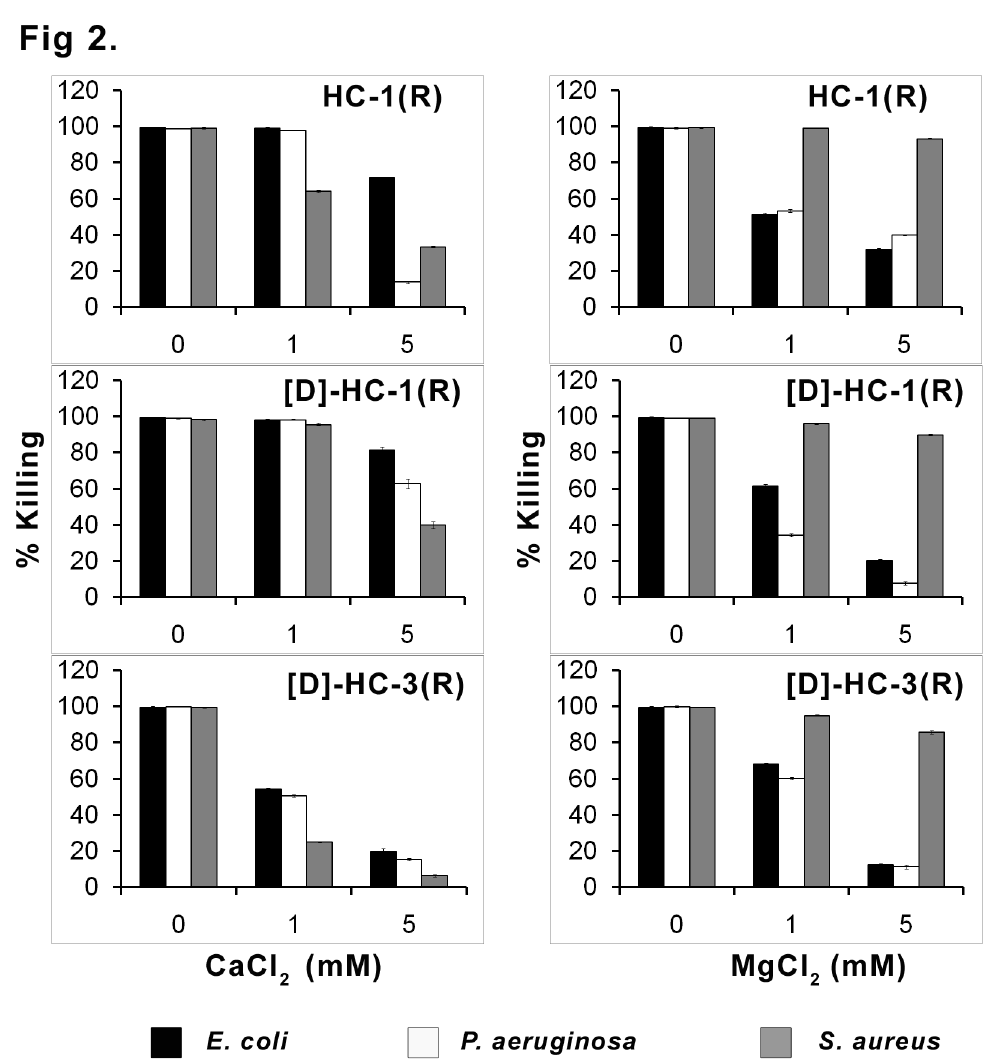
Figure 2. Effect of divalent cations on antibacterial activity. Mid-log phase bacteria (10 6 CFU/mL) were incubated with peptides at their LC in the absence or presence of the indicated concentrations of CaCl three independent experiments and the error bars represent standard deviation of the measurements. Standard deviation values ranged between